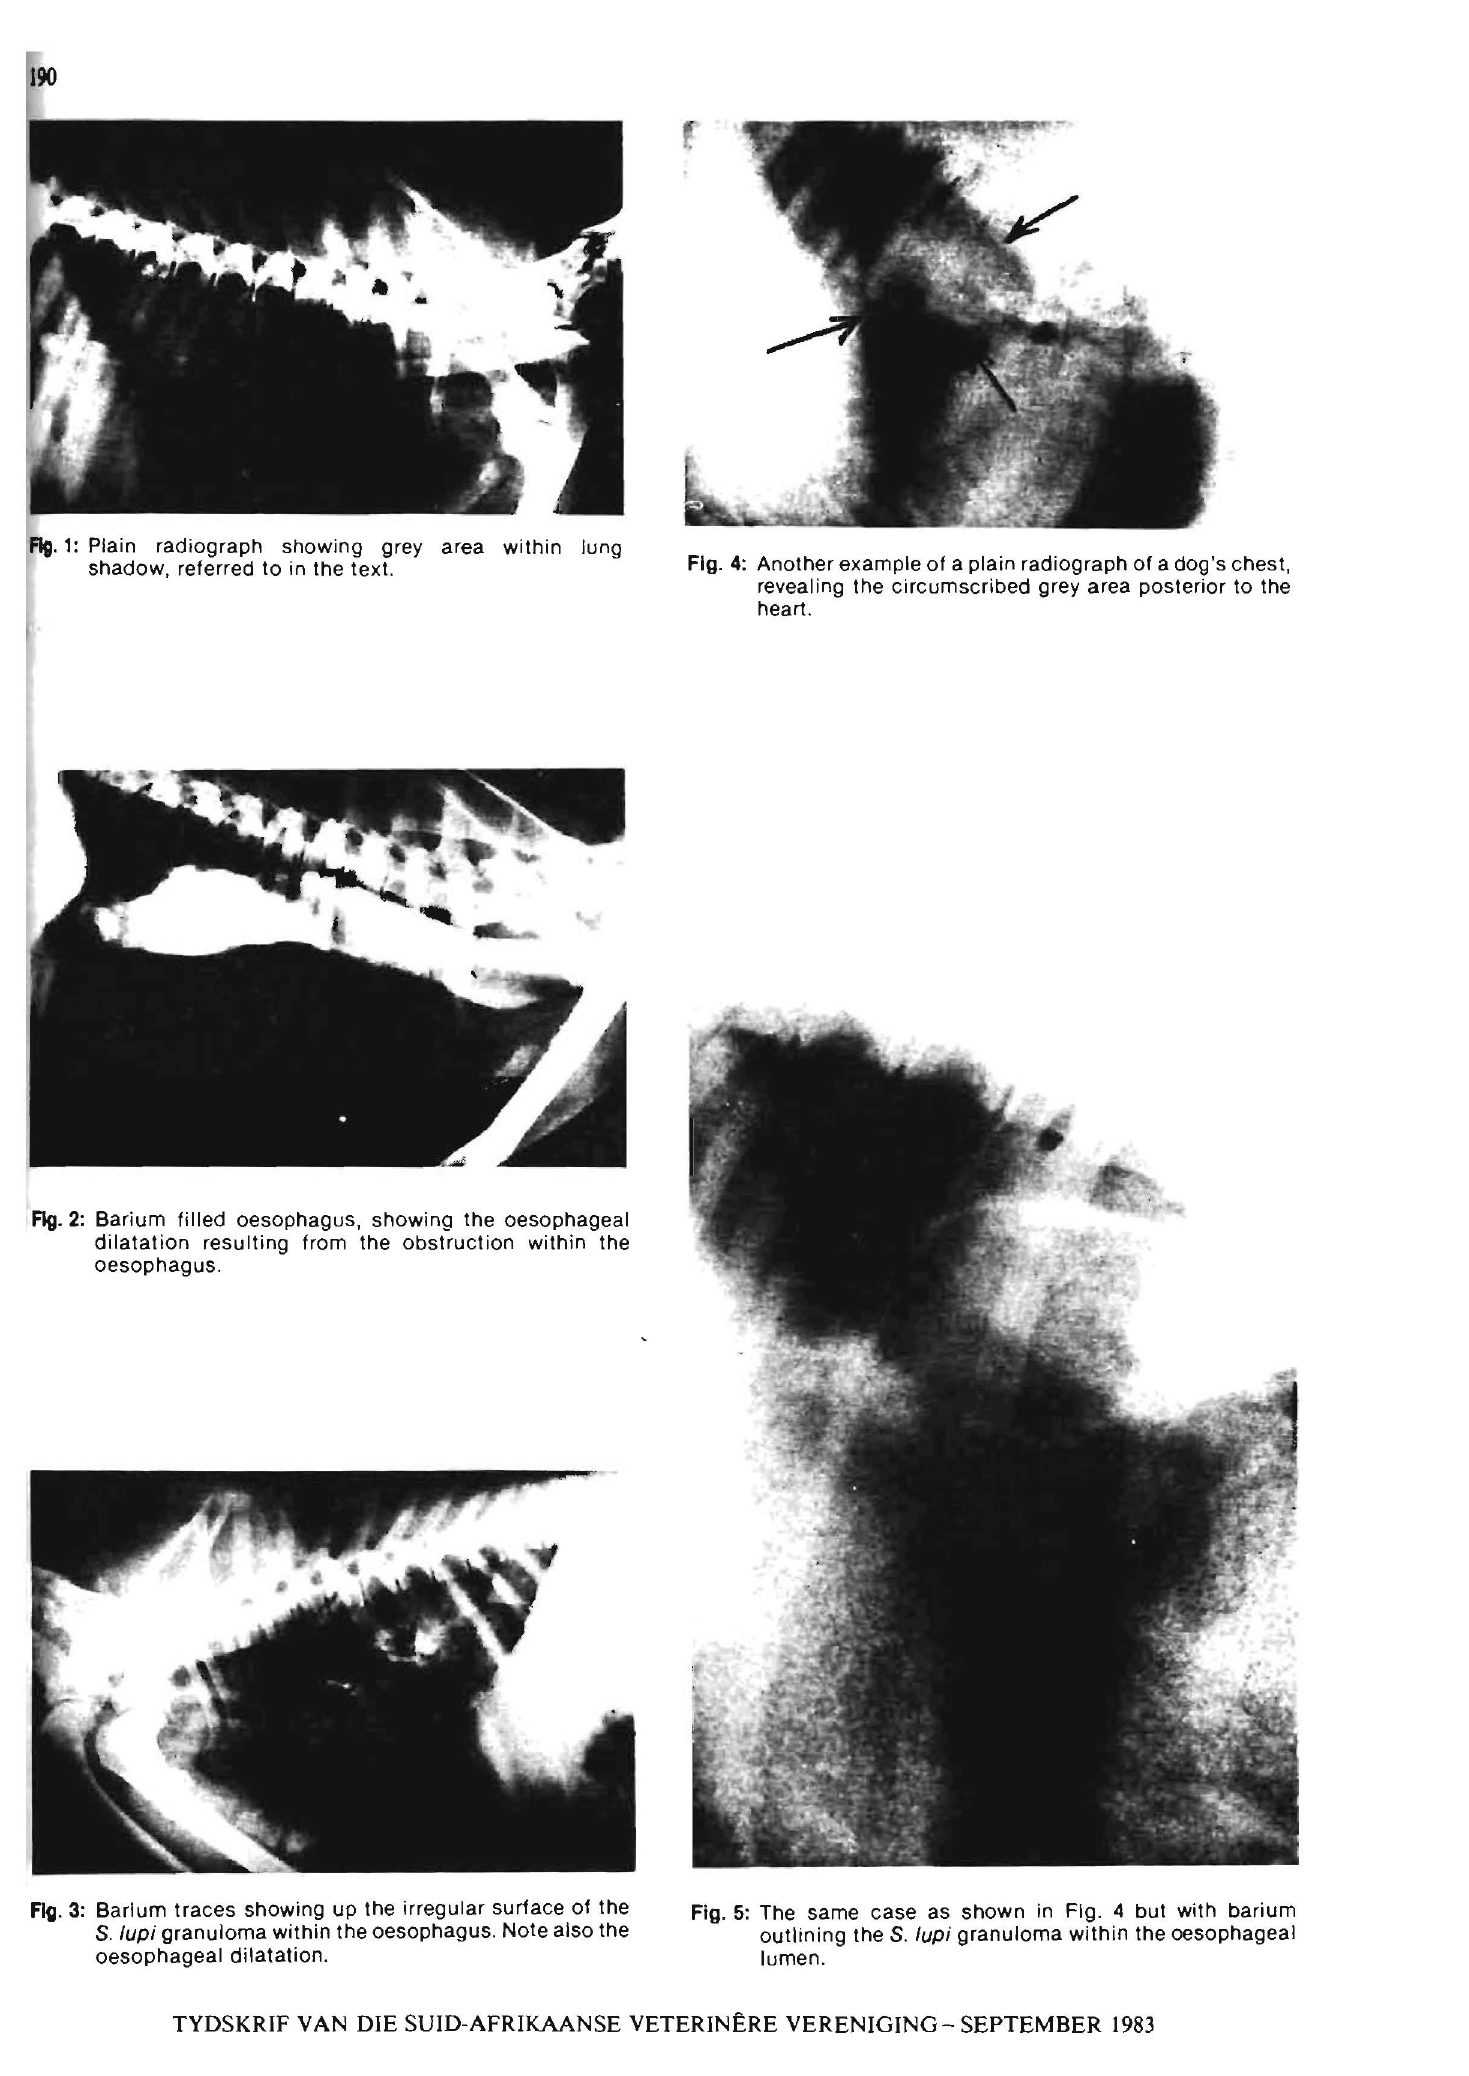
Fig. 3: Barium traces showing up the irregular sunace of the S. lupi granuloma within the oesophagus. Note also the oesophageal dilatation.